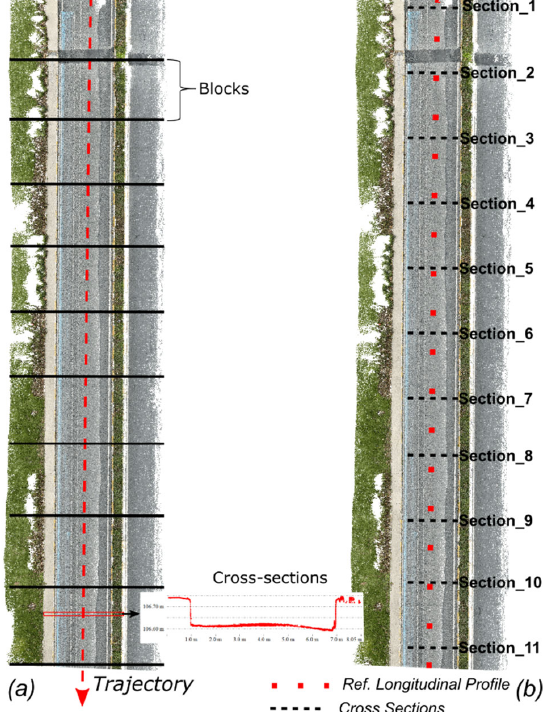
Figure 5, a) Splitting the study area into rectangular blocks and forming cross-sections, b) red dots show reference longitudinal profile points in the study area, black dashed lines indicate reference cross-sections. Following the detection of candidate curb points, the road boundaries were segmented into left and right road